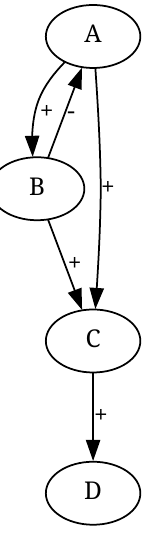
Figure 6 – Influence graph of the example BN g for